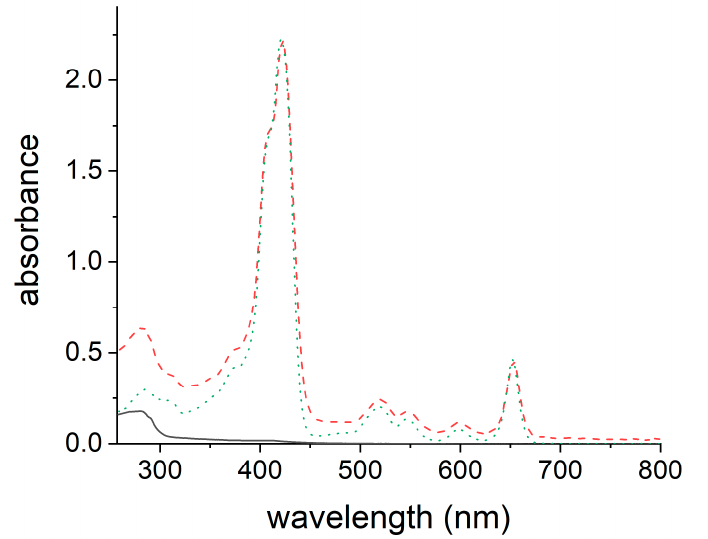
Figure 6. UV-Vis spectra of mTHPC@apoMb (dashed red line) in PBS, apoMb (solid black line) in PBS, and mTHPC in DMSO (dotted green line). PBS, and mTHPC in DMSO (dotted green line).